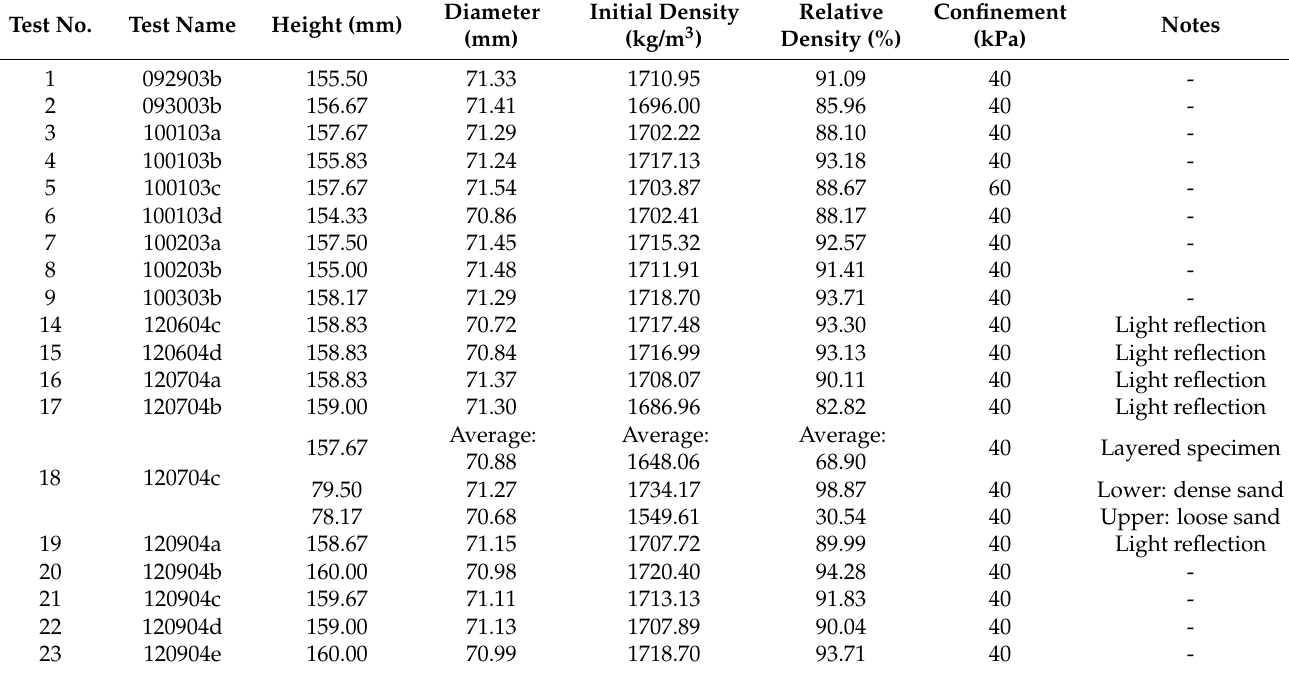
Table 1. Experimental characteristics of multiple-layered sand specimens prepared by vibratory compaction (heterogeneous